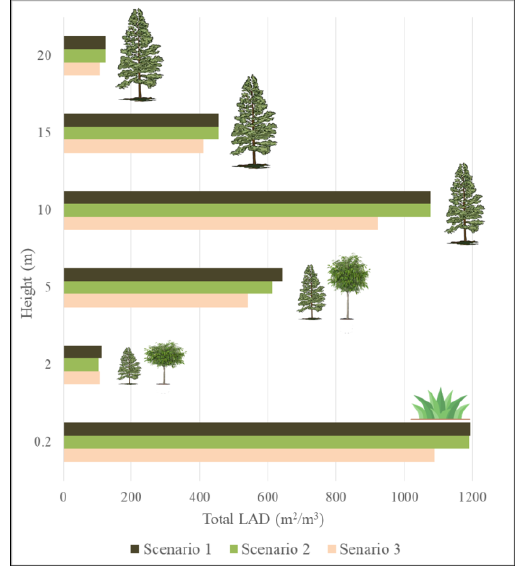
Figure 6. Variations in the total LAD for each simulation scenario in Lower Session Road, Baguio City. Each height range is dominated by either grass, Balete trees, Pines, or a combination of two vegetation types.